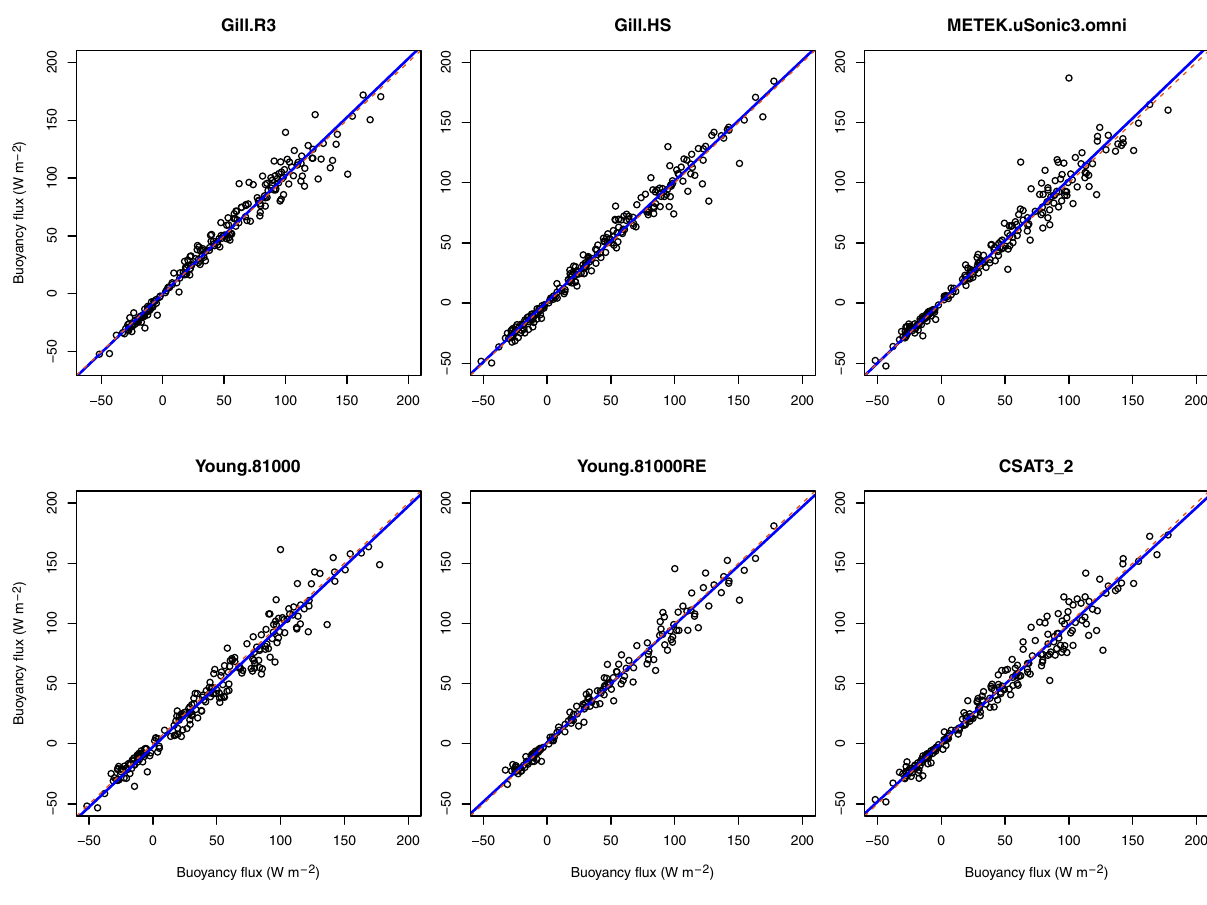
Figure 9. Comparison of buoyancy flux measurements (etalon = CSAT3_1). Table 7. Regression results for the comparison of buoyancy flux H s , plus estimates for bias and comparability (RMSE). Etalon =